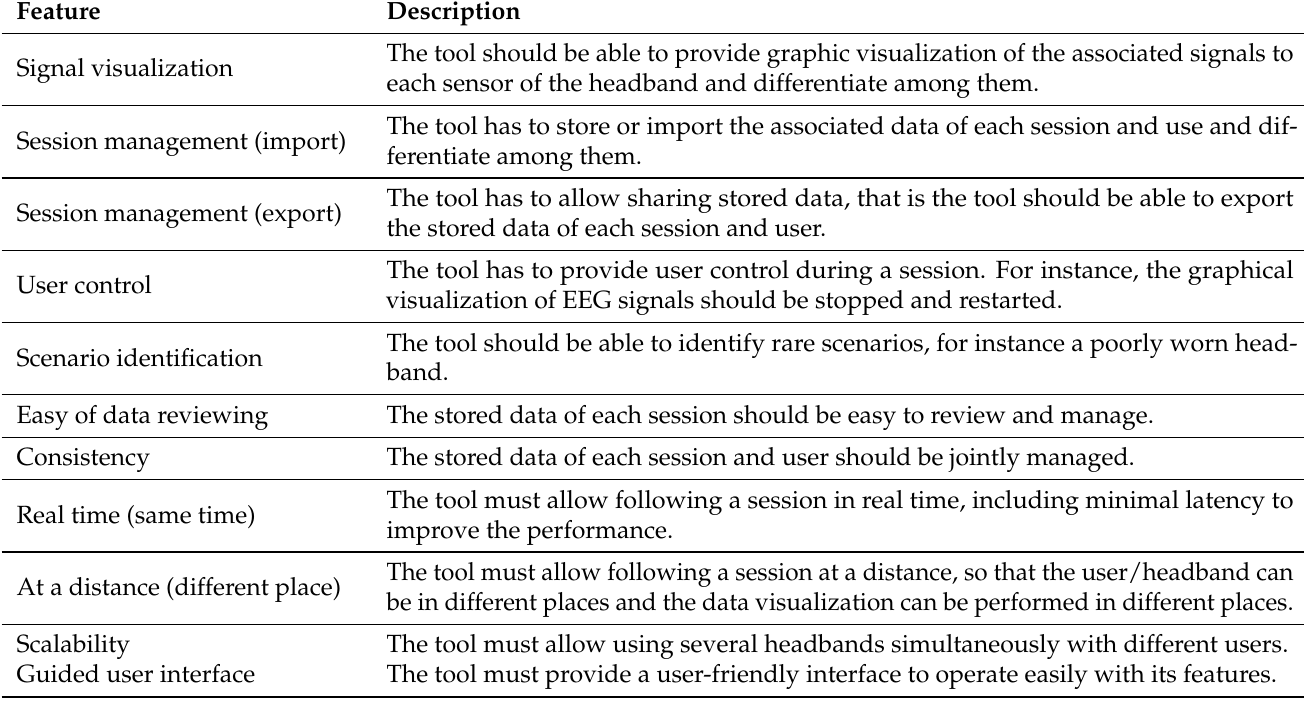
Table 1. List of features for MuseStudio’s